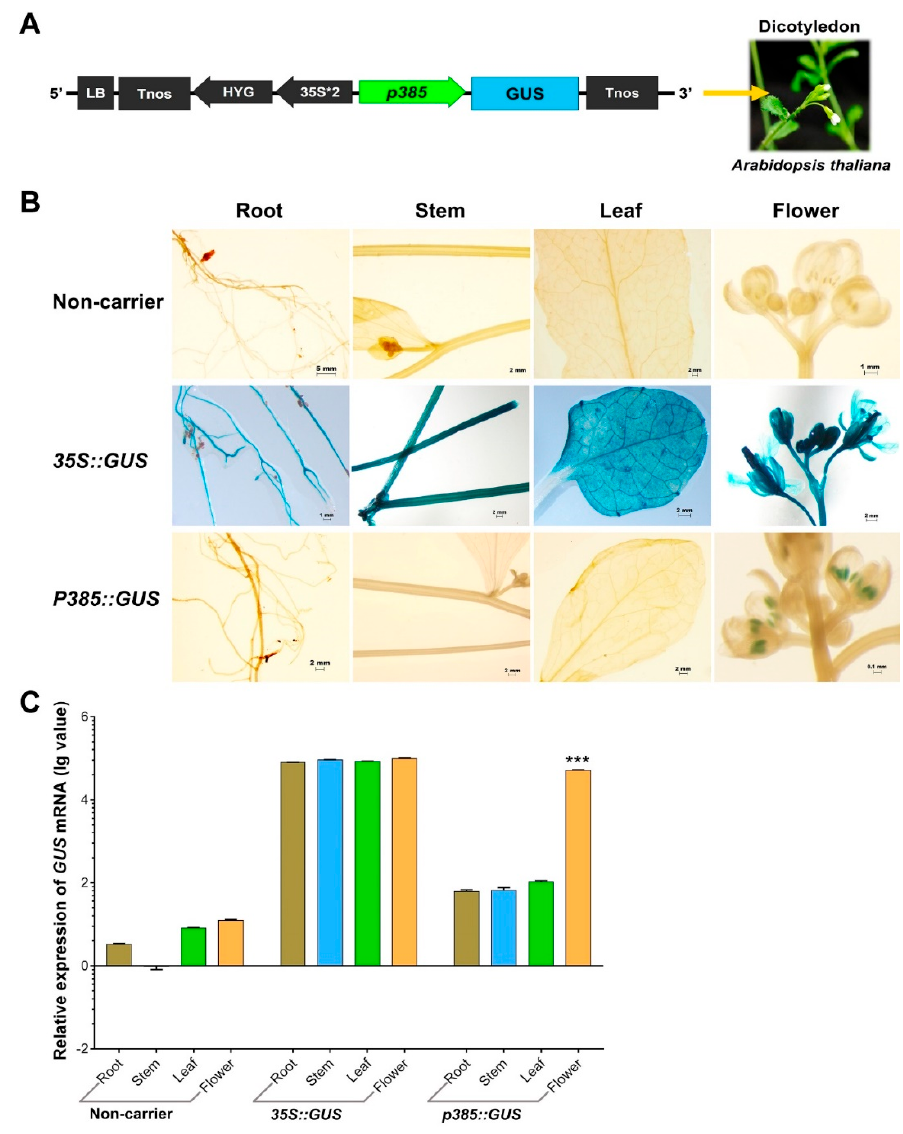
Figure 4. GUS expression in p385:: GUS rice transformants in contrast to non-carrier plants and 35S:: GUS lines. ( A ) Linear map of the p385:: GUS vector for transgenic Arabidopsis . ( B ) Histochemical localization of GUS activity in vegetative tissues from stably transformed rice plants. The columns from left to right indicate the root, stem, leaf, and panicle. The lines from top to bottom indicate the tissues from non-carrier, 35S, and p385 lines. ( C ) The relative GUS transcript expression assayed by qRT-PCR in the root, stem, leaf, and panicle tissues harvested from p358 rice transformants compared to non-carrier plants and 35S:: GUS transgenic lines. Brown bar chart: root; blue bar chart: stem; green bar chart: leaf; orange bar chart: panicle. Data are shown as mean ± SD ( n = 3), student’s t -test. *** represents highly significant differences from all tested tissues of each transgenic plant. Relative expression was calculated as: lg2 −ΔΔ Ct .